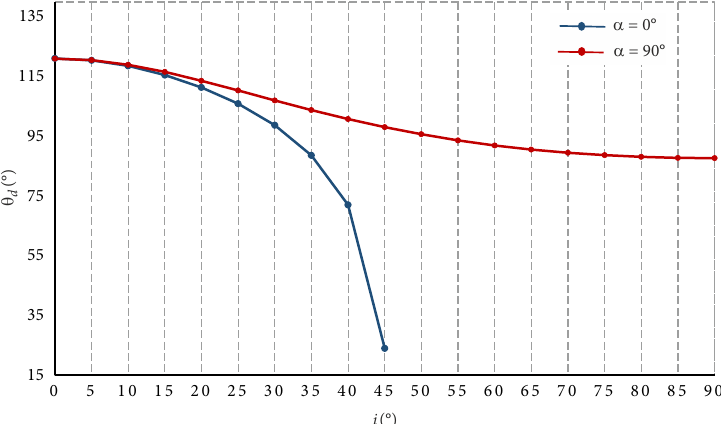
Figure 14. Failure width versus orientation angle for the reverse faulting stress